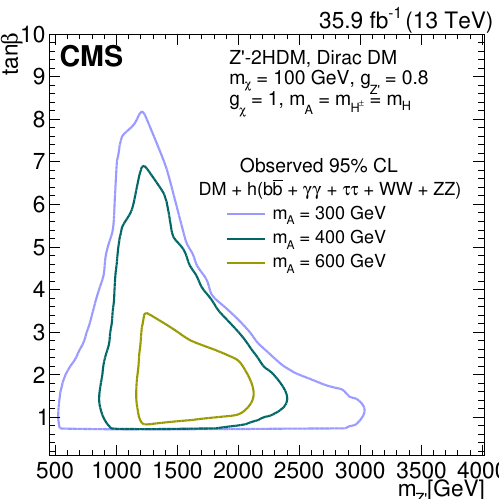
Figure 10 . The upper limits at 95% CL on the observed (cid:27)=(cid:27) plane from the combination of the (cid:12)ve Higgs boson decay channels. Each contour represents the excluded region for a given value of m